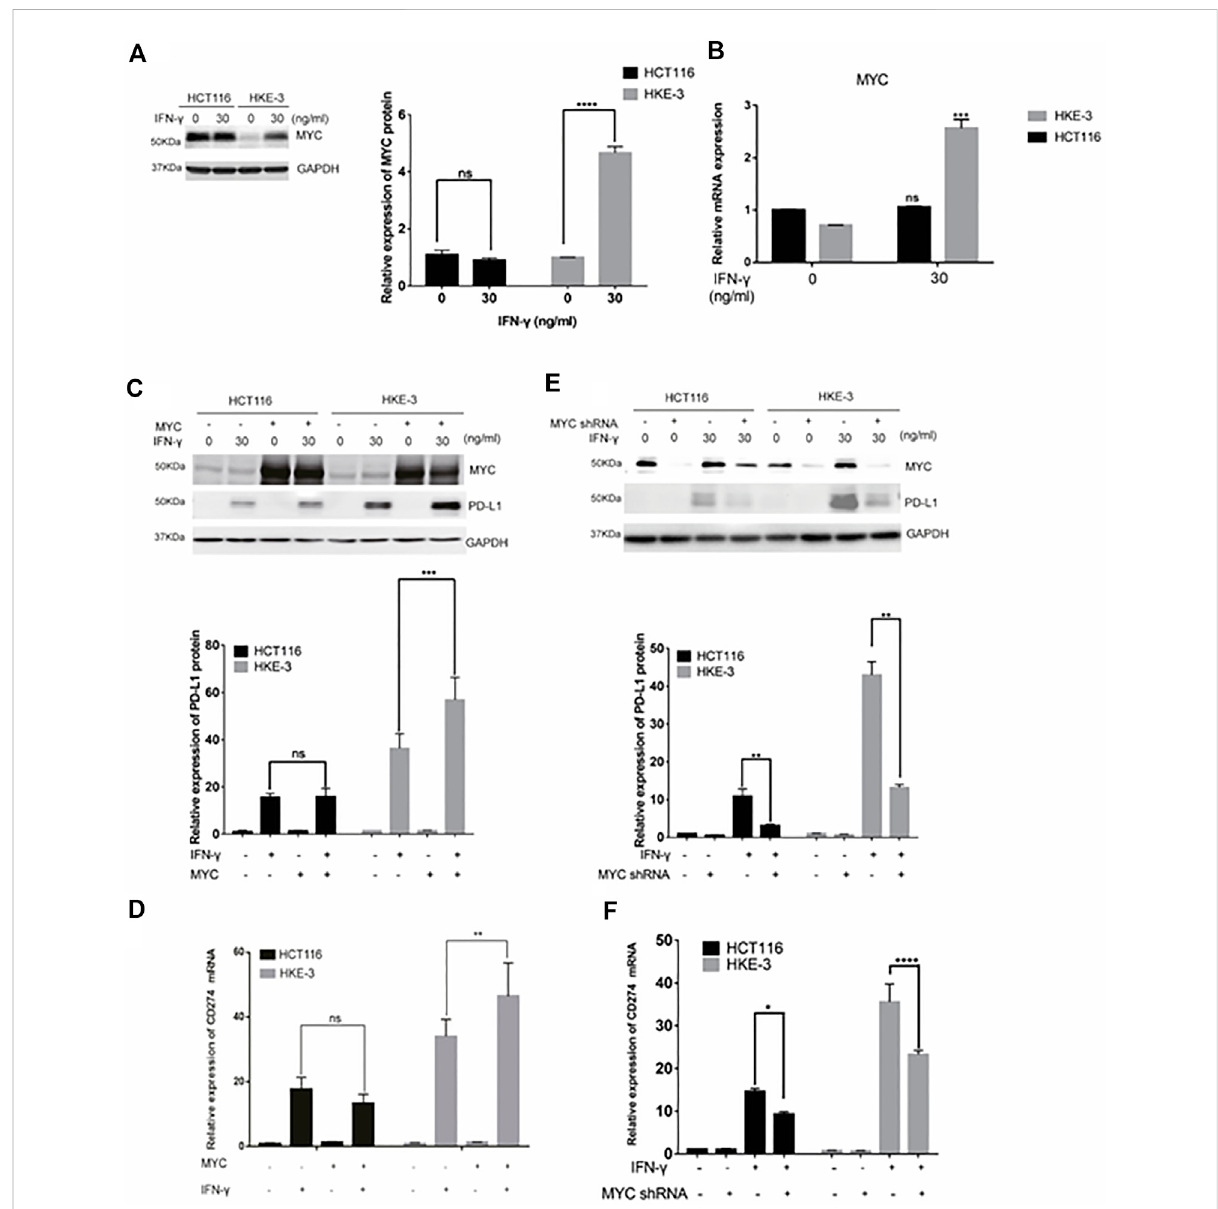
MYC-mediated IFN- γ -induced PD-L1 expression. (A) Cells were pretreated with IFN- γ . Then, the cells were collected for Westernblot analysis. Treatment with IFN- γ induced MYC expression. (B) Cells were pretreated with IFN- γ . Then, the cells were collected for RT-PCR analysis. *** p < 0.001 vs. no IFN- γ . (C,D) Cells were transfected with MYC-overexpression plasmid. Then, the cells were treated with IFN- γ . After treatment, cells were collected for Western blot and RT-PCR analyses. MYC overexpression upregulated IFN- γ -induced PD-L1 expression. (E,F) Cells were transfected with MYC knockdown plasmid. Then, cells were treated with IFN- γ . After treatment, the cells were collected for Western blot and RT- PCR analyses. Downregulation of MYC decreased IFN- γ -induced PD-L1 expression. * p < 0.05, ** p < 0.01, *** p < 0.001, and **** p <